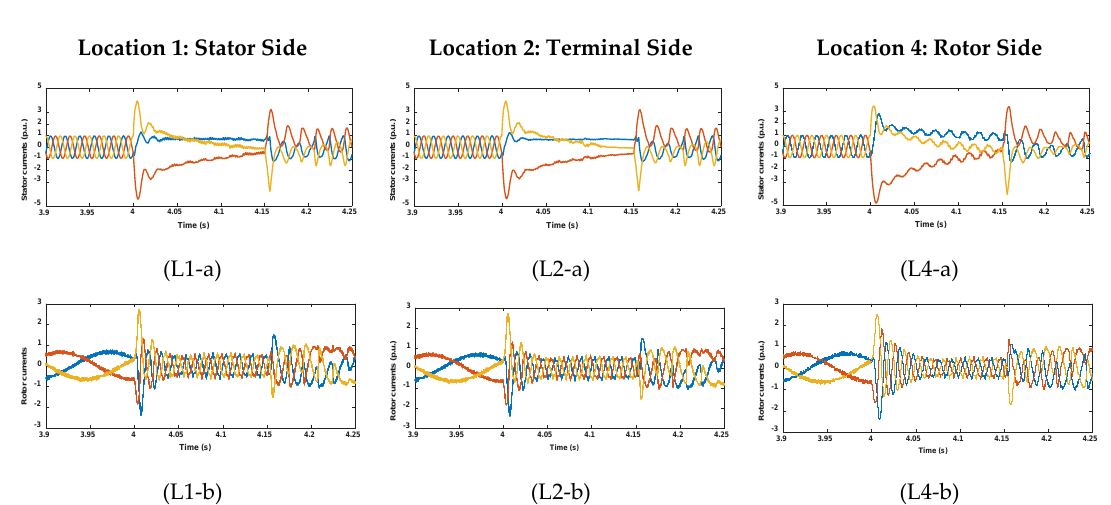
Figure 12. With the inductive type fault current limiter in the stator side (L1), in the terminal side (L2), and in the rotor side (L4) during a three-phase fault: ( a ) The stator currents; and ( b ) the rotor currents.